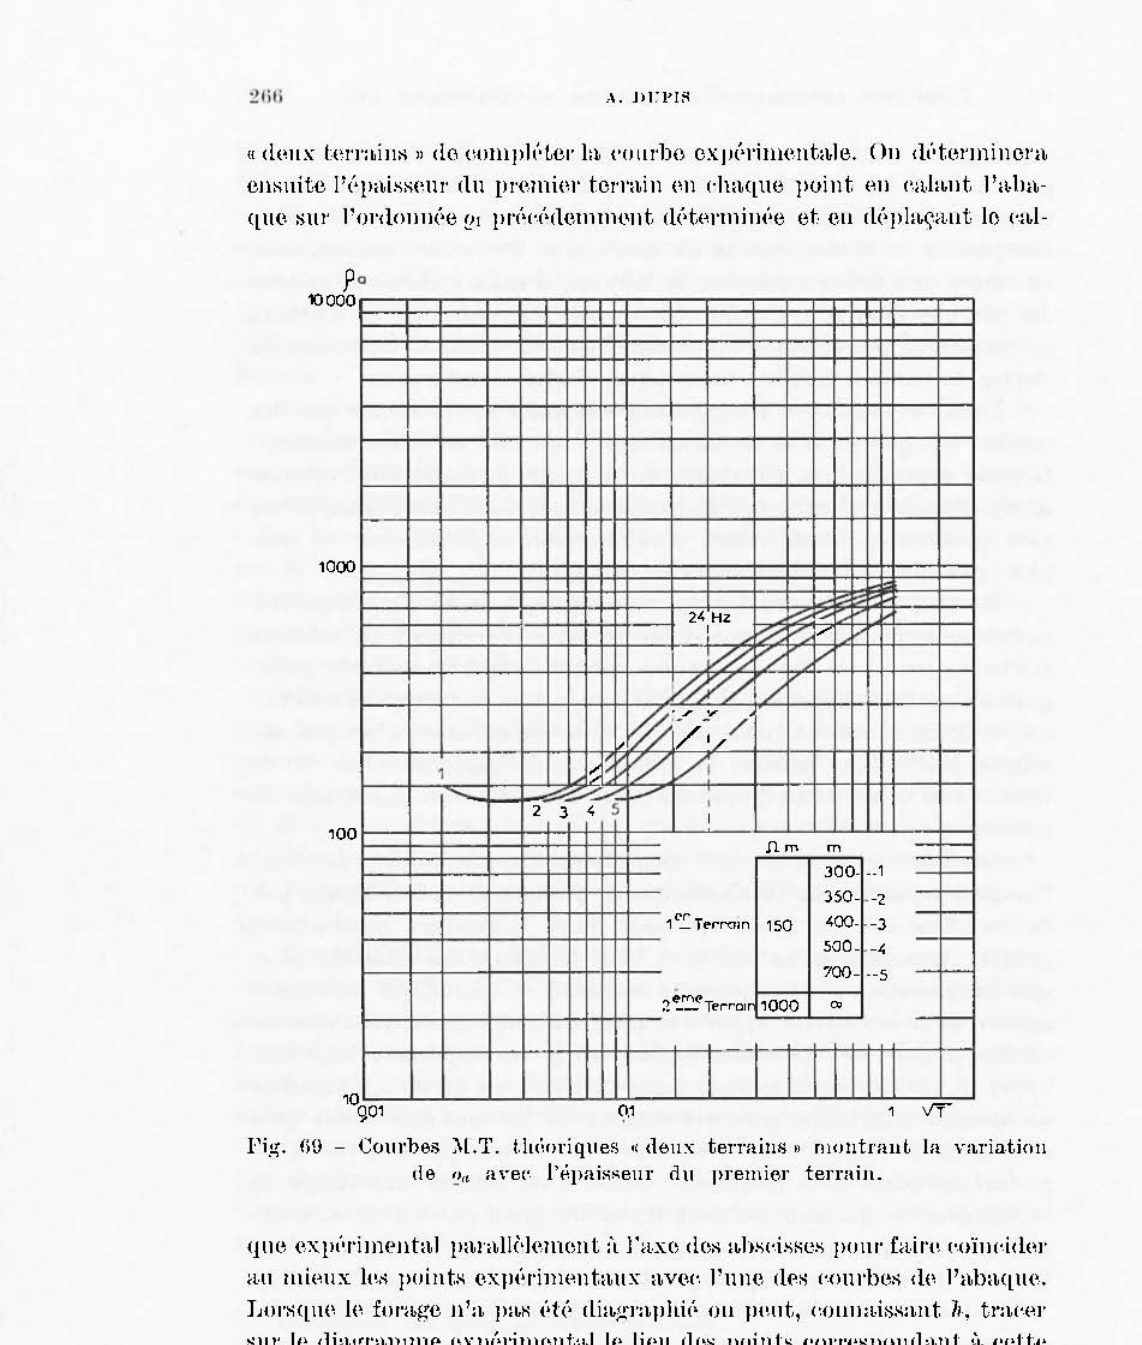
Fig. 1m COIll'bes :lL'1'. t.lu',()riqlles • dellx terminI; . rIlontranL la variatioll de '!" al'et', l't;paiH~ellr ÒIl prelllÌer terraill. ijlW expl'rill1l'ntal pamlJ('lement:'t l'a,xe (les l~h.~('i.~KC.~ !)(ml' bir'p ('()lll('i(h~l' a,1l lllip\lx Ip.~ pOillt.~ exp('r'inwntaux ave(', 1'I1ne dl'~ (',ol1l"bes (h~ l'almque. Jml'Kqlw il~ for'a,ge n'a ImH t'>t(, (lil~!..!.Taphil' Oll pPl1t, ('Ollna.is.~allt h.